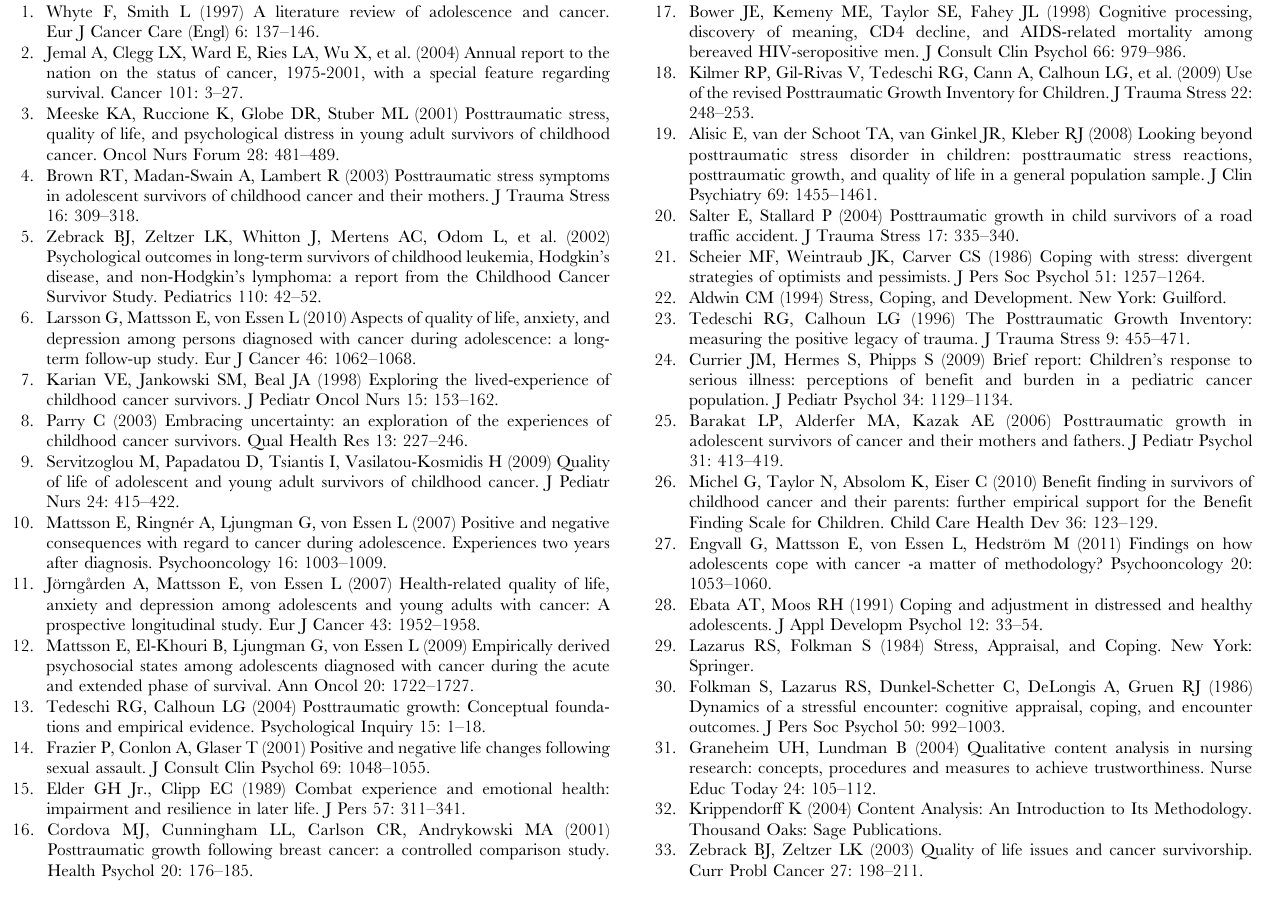
Table S1 A presentation of identified categories, cate- gory content, and examples of statements about nega- tive and positive cancer-related consequences three (T6) and four (T7) years after diagnosis (N= 32). Table S2 A presentation of the number of persons reporting only negative, negative and positive, and only positive cancer-related consequences two a (T5), three b